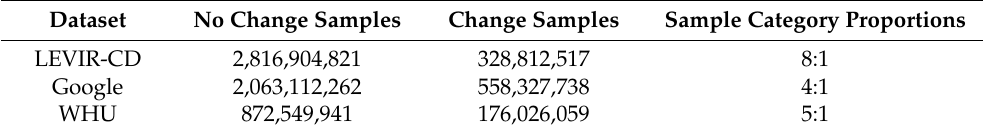
Table 2. Processed data distribution of building change detection datasets.